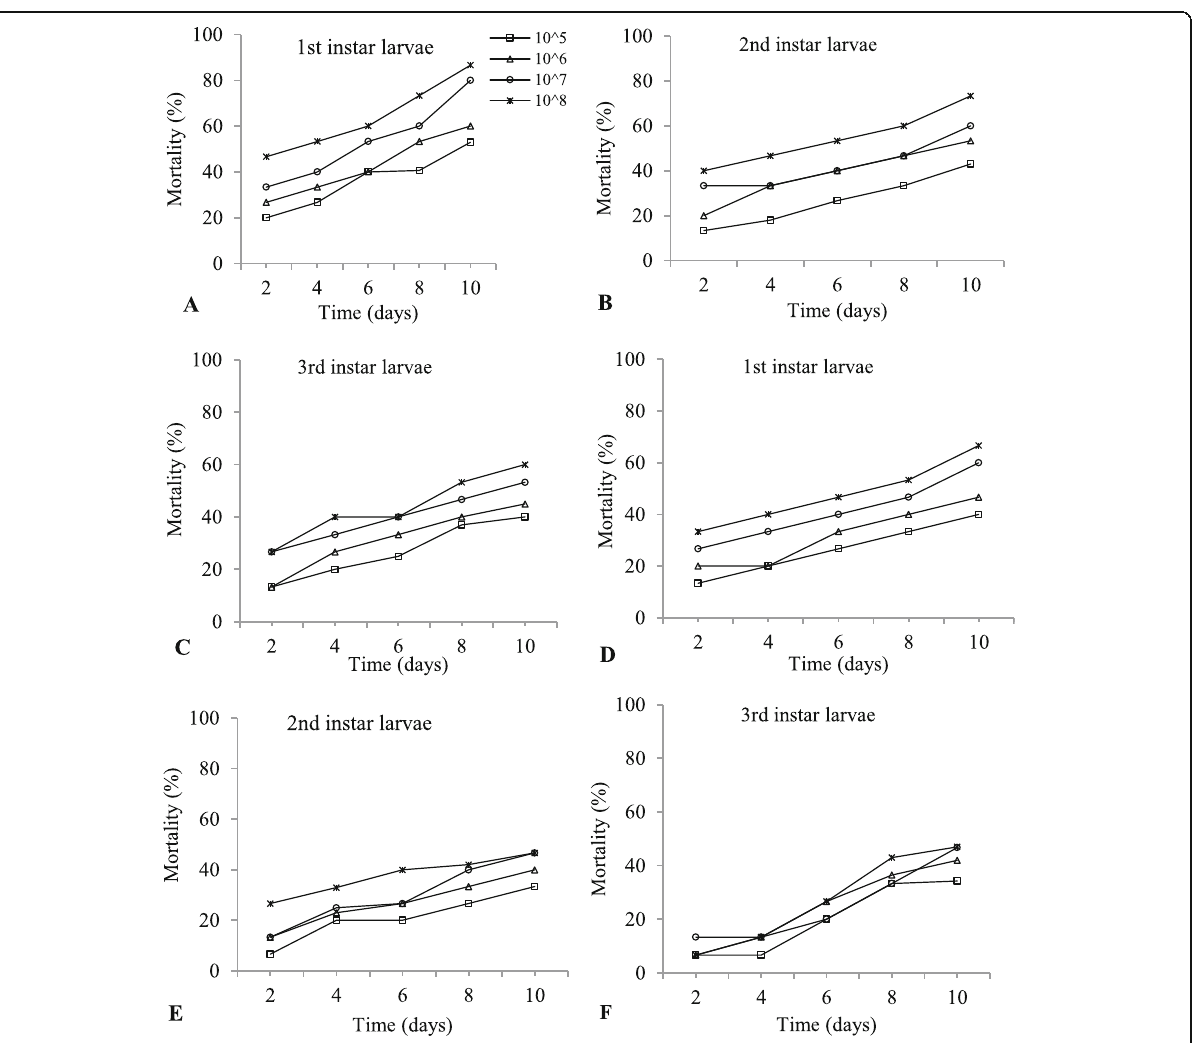
Fig. 1 The mortality trend of different larval instars of Xanthogaleruca luteola treated by Beauveria bassiana during different times using immersion ( a, b, c ) and spraying ( d, e, f )